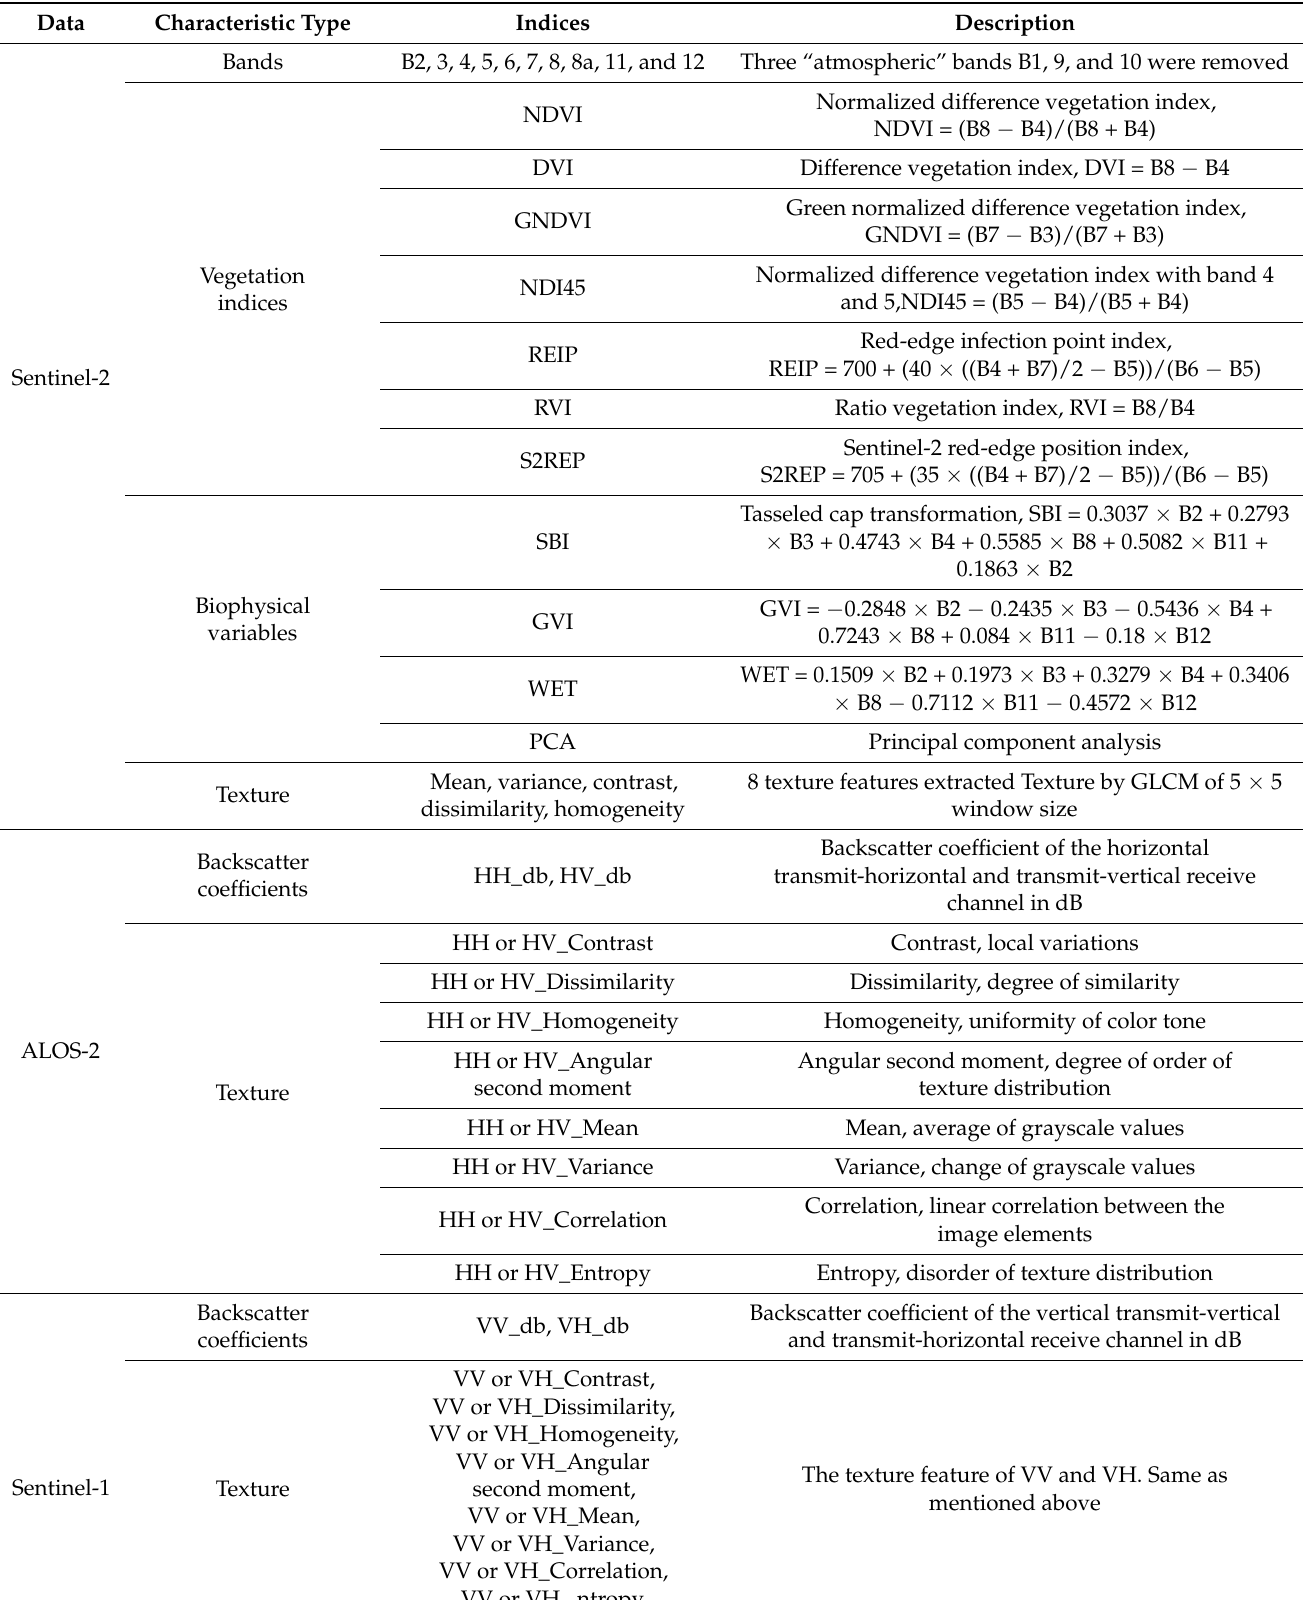
Table 3. Description of different indices from remote-sensing